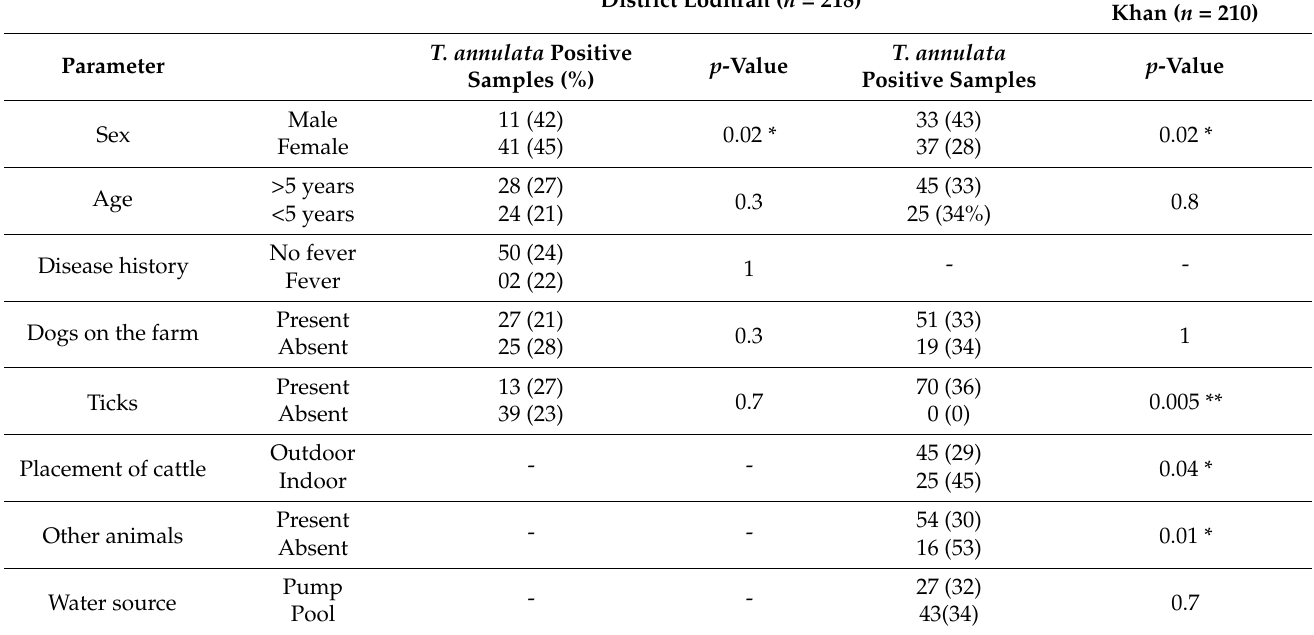
Table 3. Association of Theileria annulata infection with the studied epidemiological data of cattle enrolled from Districts Lodhran and Dera Ghazi Khan. The percent prevalence of T. annulata is given between parentheses. p -values indicate the results of Fischer exact test calculated for each